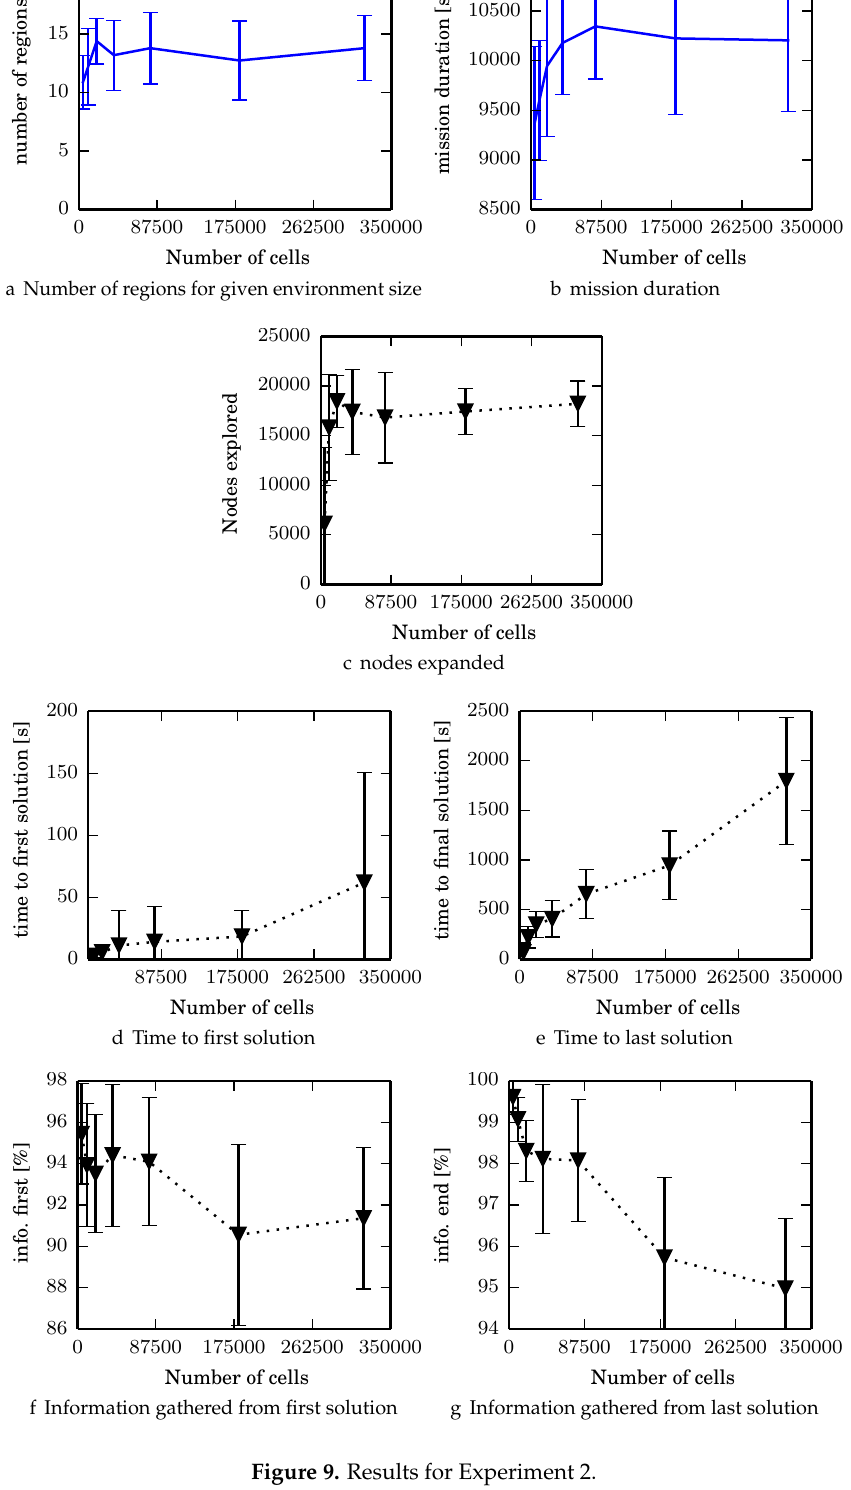
Figure 9. Results for Experiment